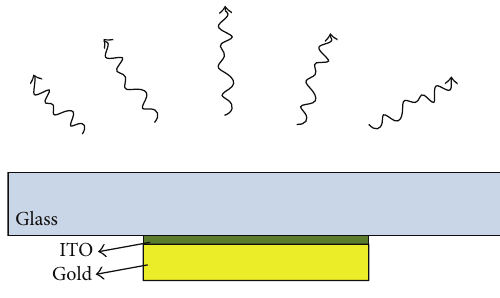
Figure 1: Glass superstrate antenna.